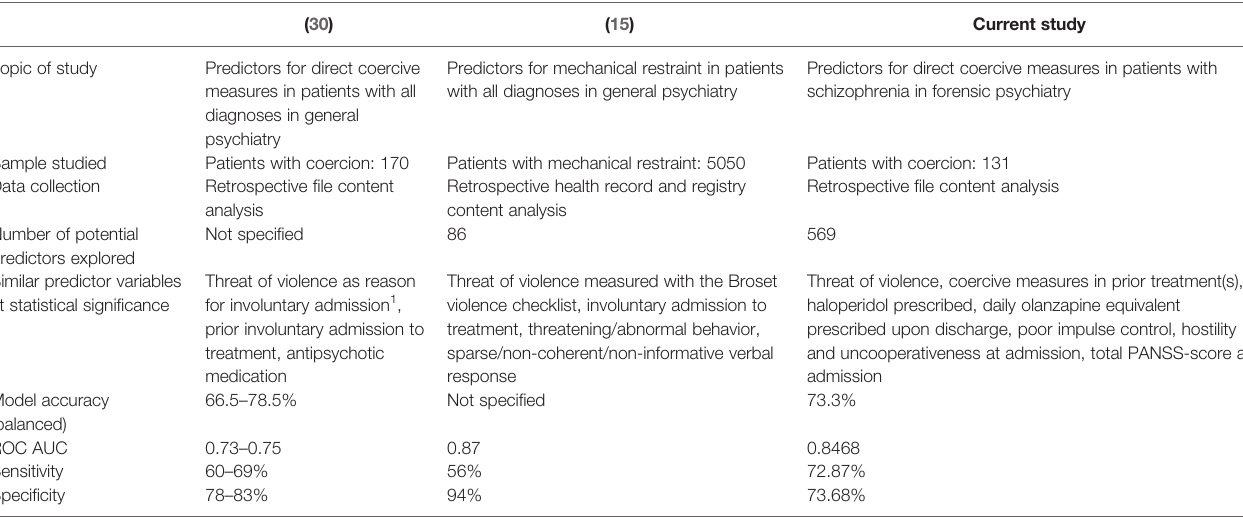
ROC AUC, receiver operating characteristic curve area under the curve method, a measure for the goodness of fi t of a model (67); PANSS, Positive and Negative Symptom Scale. 1 Authors see a limitation in their measuring threat of violence only in terms of reason for involuntary admission.